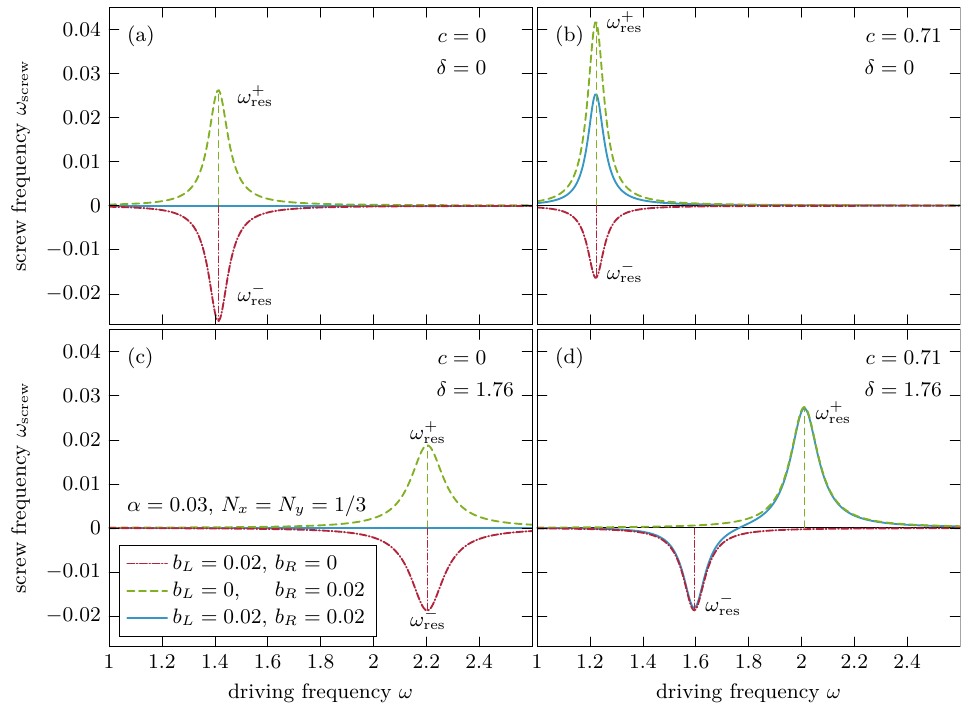
Figure 2: Dimensionless rotation frequency ω of the magnetic texture plotted as screw a function of ω for different polarizations of driving magnetic field: left-circular po- larized in red / dashed-dotted, right-circular polarized in green / dashed, and linearly = N = 1 / 3, γ < 0). Panels (a) and (b) polarized in blue / solid (with α = 0.03, N x y discuss the case without dipolar interactions ( δ = 0), exactly described by Eq. (37), while dipolar interactions are included in panels (c) and (d), with δ = 1.76, see App. C and Eq. (40) for the approximate behavior of ω near resonance. In the screw = 0 ( c = 0), panels (a) and (c), the left and absence of a static magnetic field, B 0 right polarized contributions are equal and opposite and cancel each other when we drive with a linearly polarized driving field (blue curve). In finite field, panels (b) and (d), one can induce a rotation even for linearly polarized fields. In the presence of dipolar interactions and static field, the resonance splits, see App. C, and the sign of ω can be controlled by changing screw